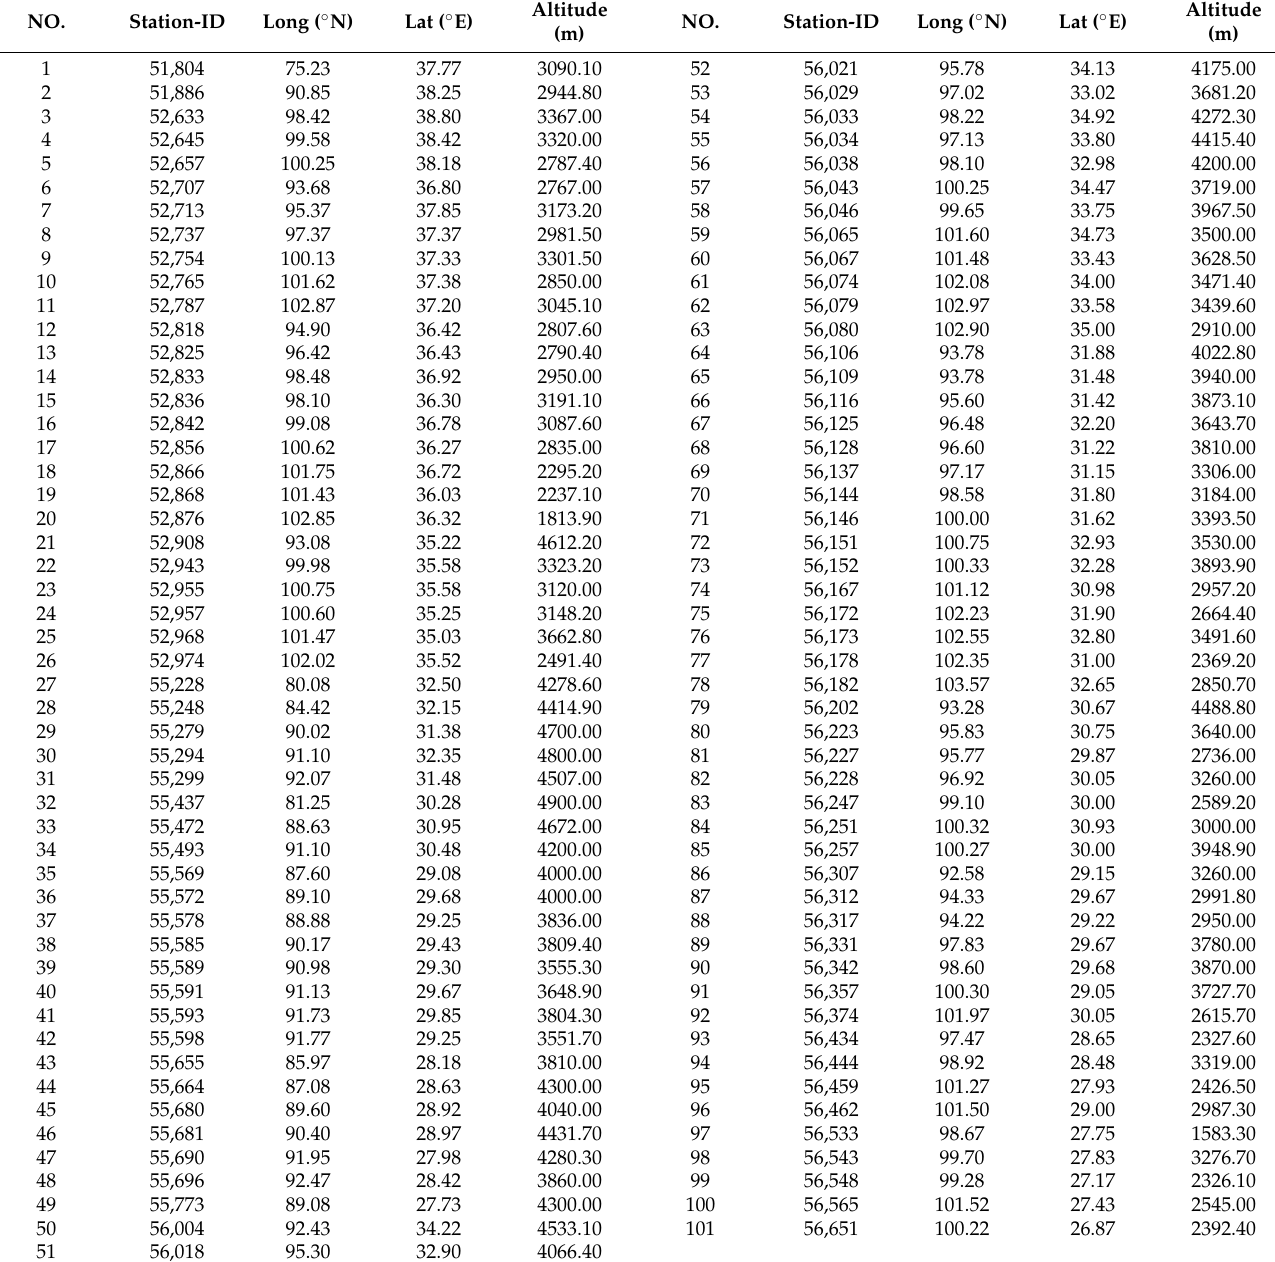
Table A1. Geographical locations and elevations of gauging stations used in the present